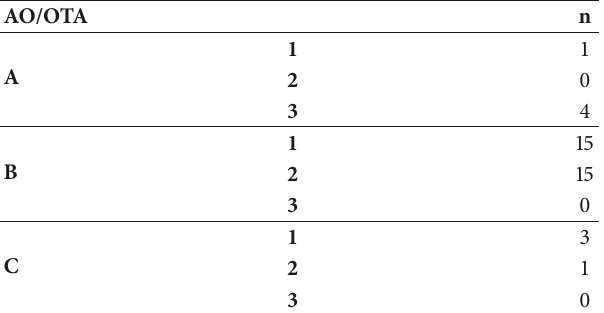
Table 1: Classification of the fractures according to AO/OTA sys-